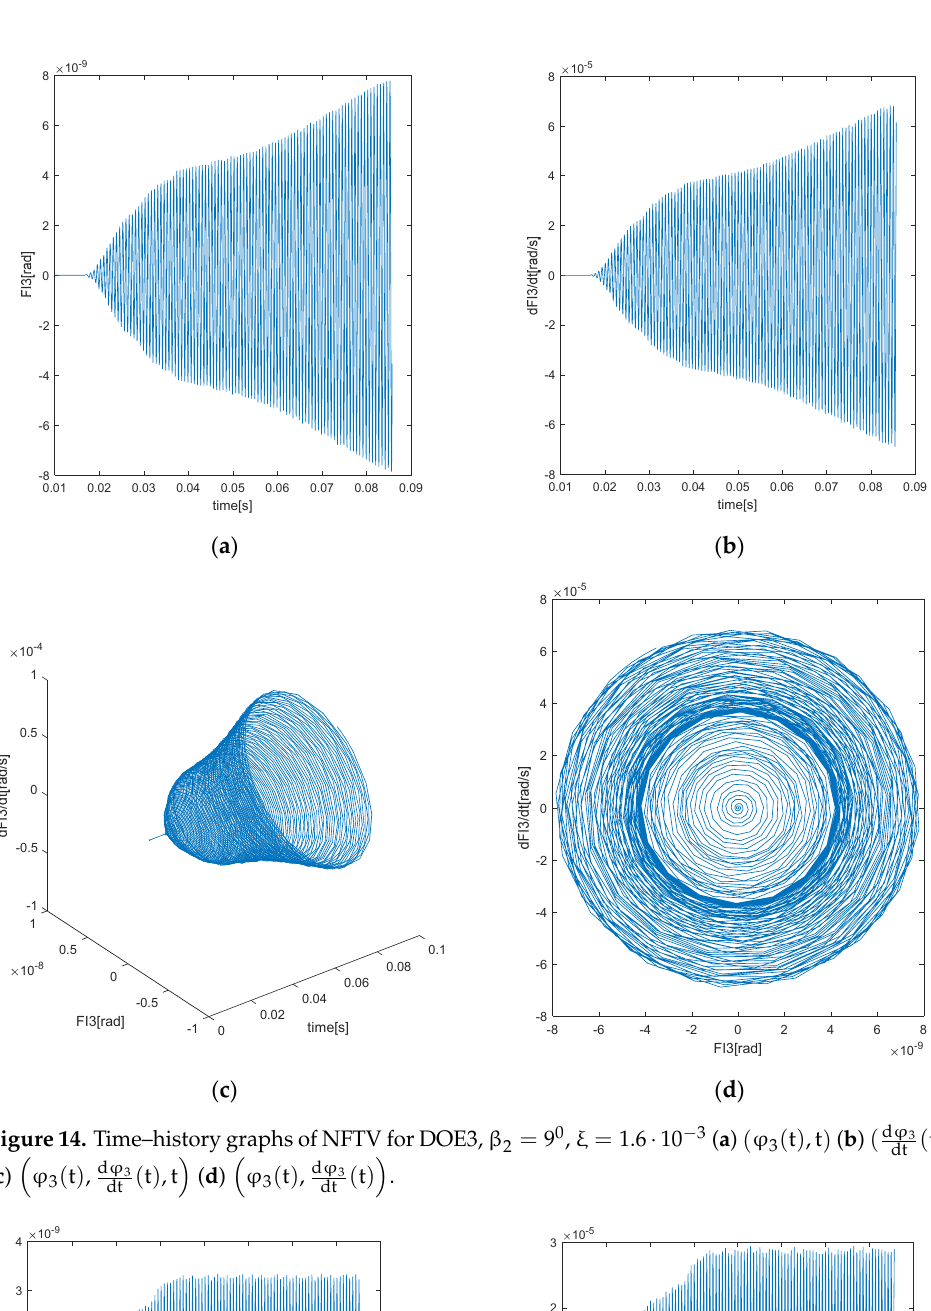
Figure 14. Time – history graphs of NFTV for DOE3, Figure 14. Time–history graphs of NFTV for DOE3, β 2 = 9 0 , ξ = 1.6 · 10 − 3 ( a ) ( ϕ 3 ( t ) ,t ) ( b ) ( d ϕ 3 (cid:16) (cid:17) (cid:16) (cid:17) ( t ) ,t ( t ) ϕ 3 ( t ) , d ϕ 3 ϕ 3 ( t ) , d ϕ 3 ( c ) ( d ) . dt dt